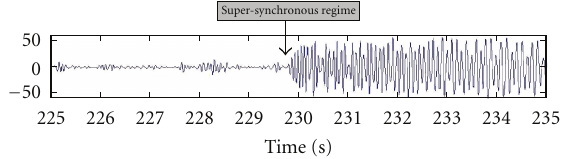
Figure 9: Wavelet decomposition for F y . Zoom on the time interval 225s < t < 235 s for f = 10 . 66 Hz ( N ref , Q n